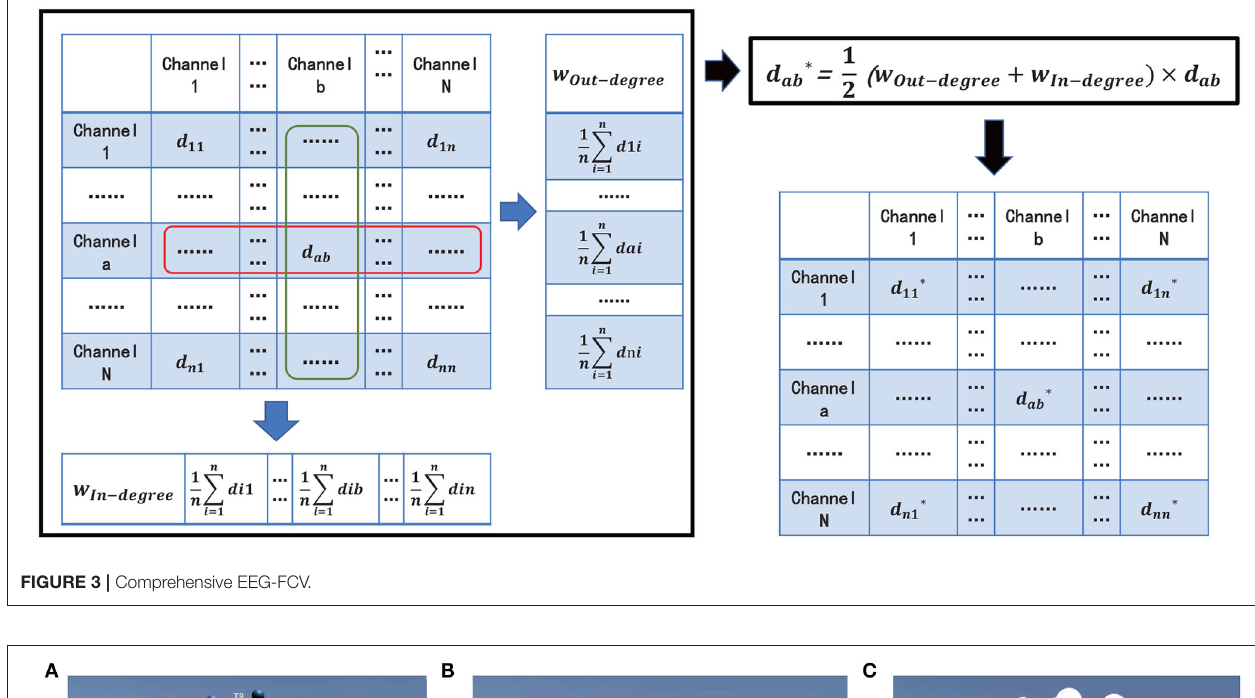
choose PCC or PLV as d ab , d ∗